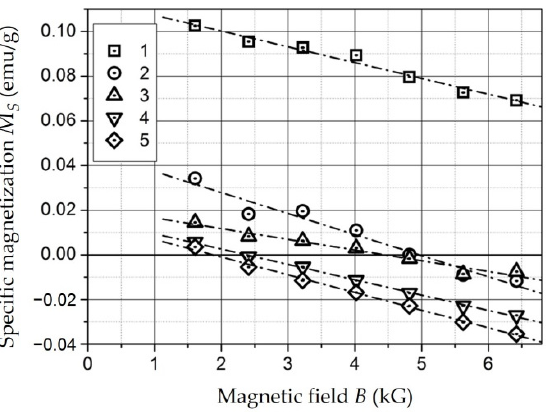
Figure 26. Magnetization curves of nanocomposites of the following compositions: (1) HPPE + 10%